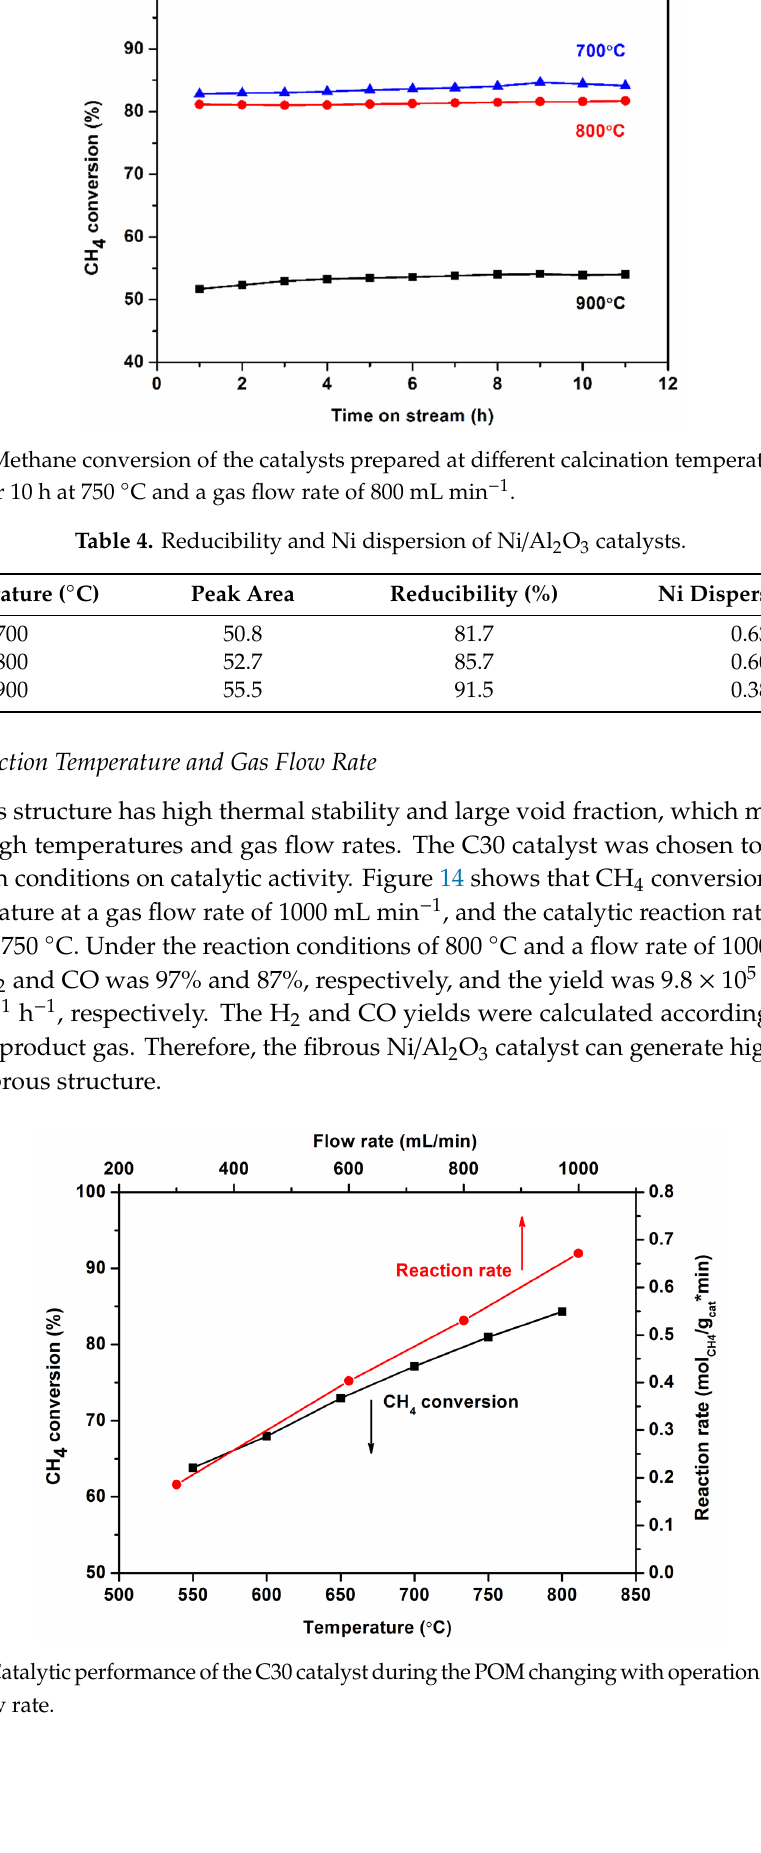
and gas flow temperature and gas flow rate.